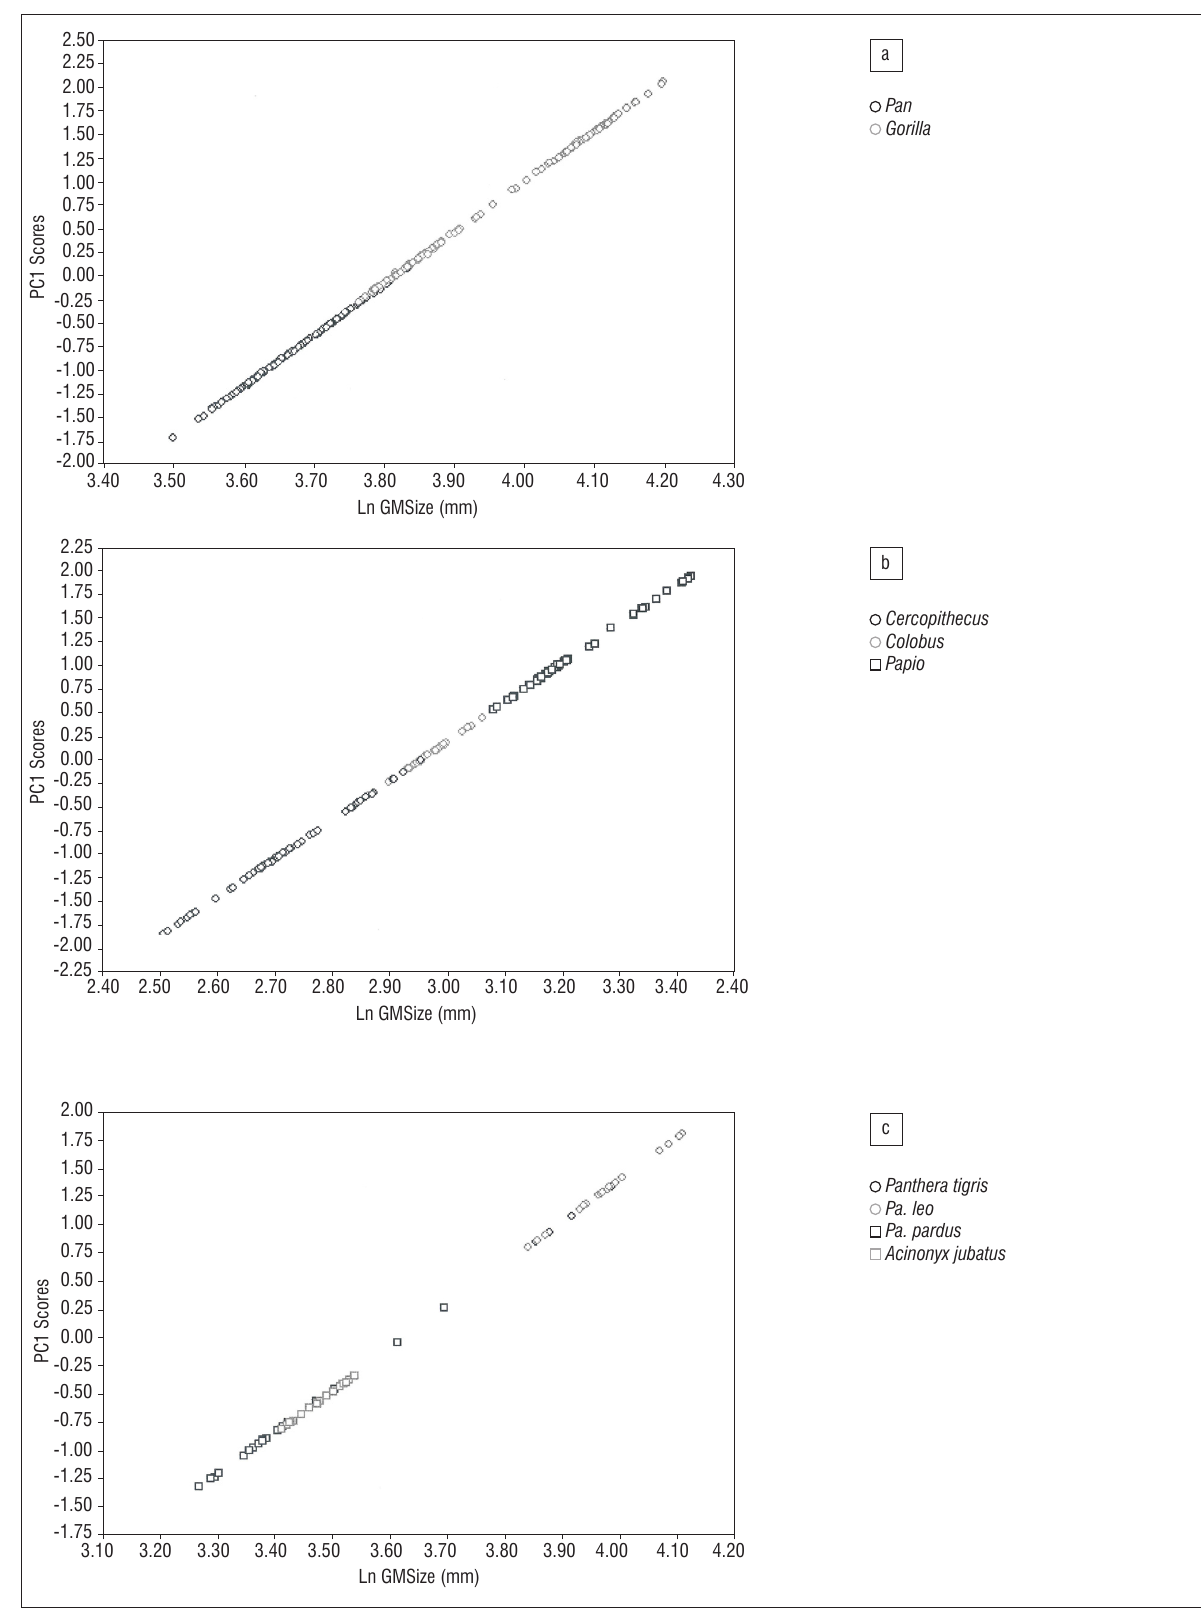
Figure 3: Bivariate scatter plots of PC1 scores ( y -axis) against GMSize of the k =8 postcranial variates in (a) extant African hominids, (b) extant Old World monkeys and (c) extant large-bodied felids. In all cases the parametric correlation (Pearson’s) is r